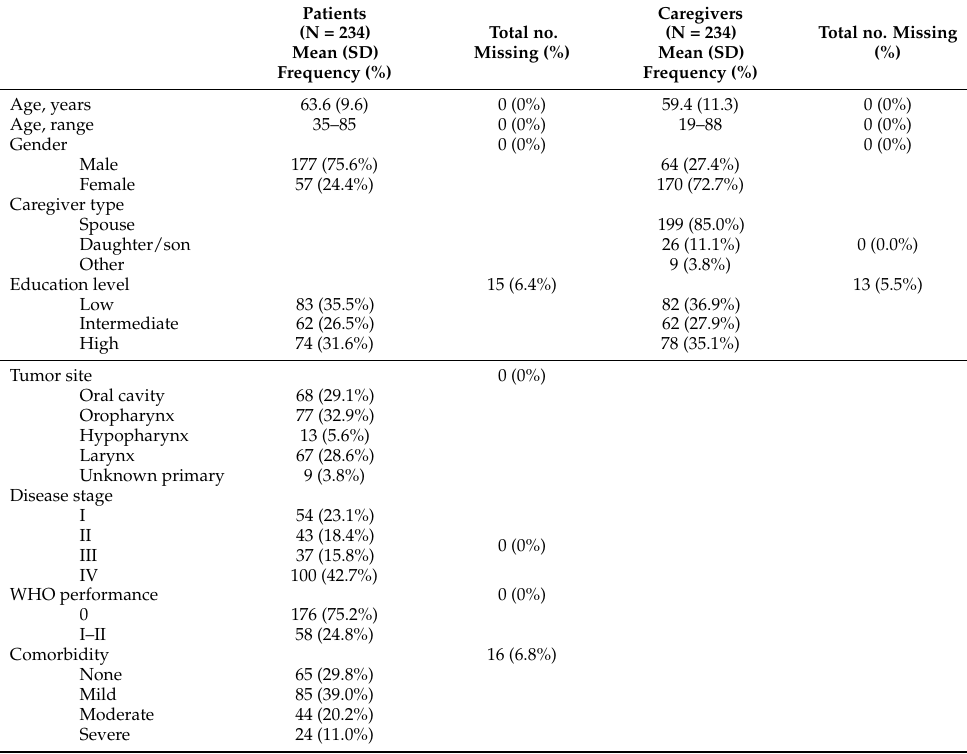
Table 1. Descriptive characteristics of informal caregivers and